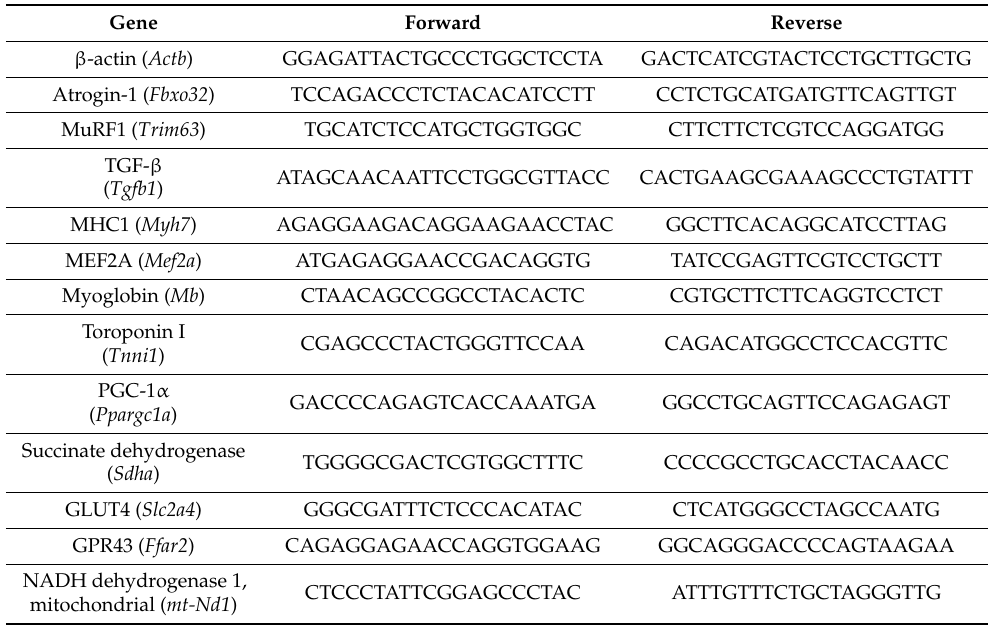
Table 1. List of sequences of PCR